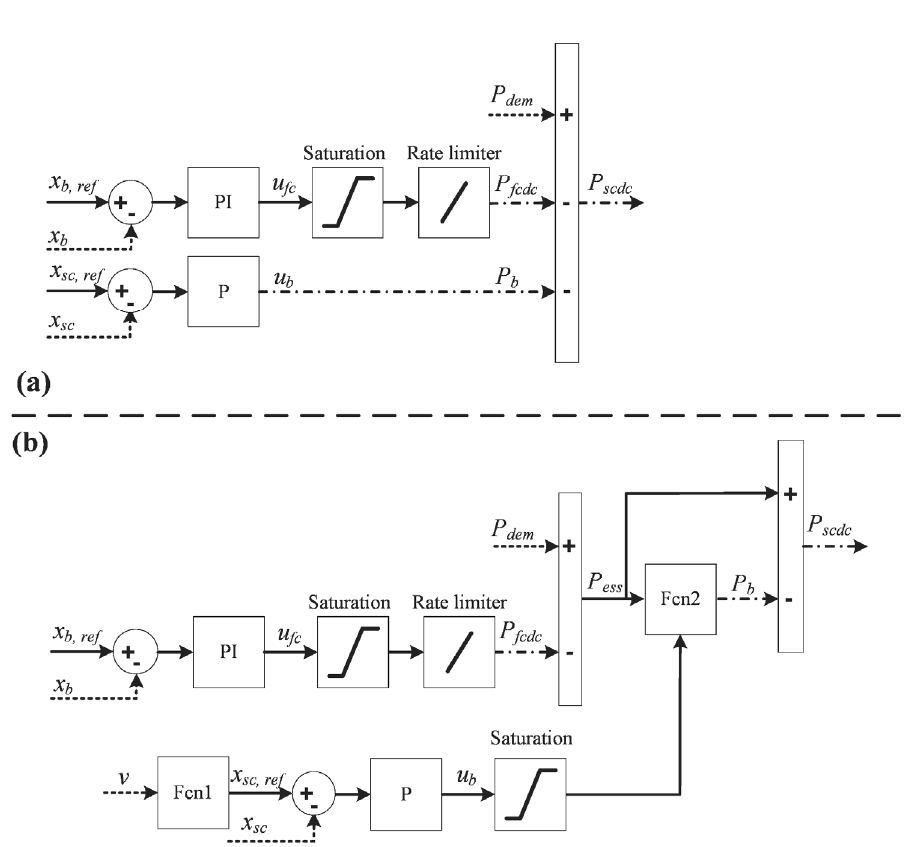
Figure 7. Schematic of the two power management strategies. ( a ) S1; ( b ) S2. The inputs represented by dotted arrows and the outputs by dash-dot